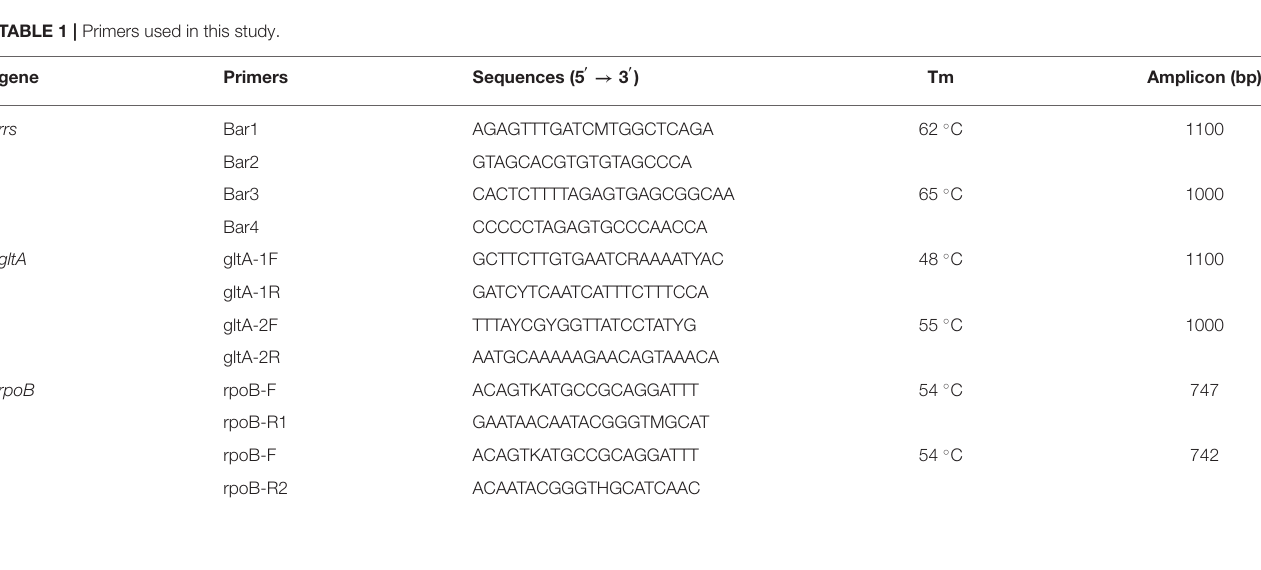
TABLE 1 | Primers used in this